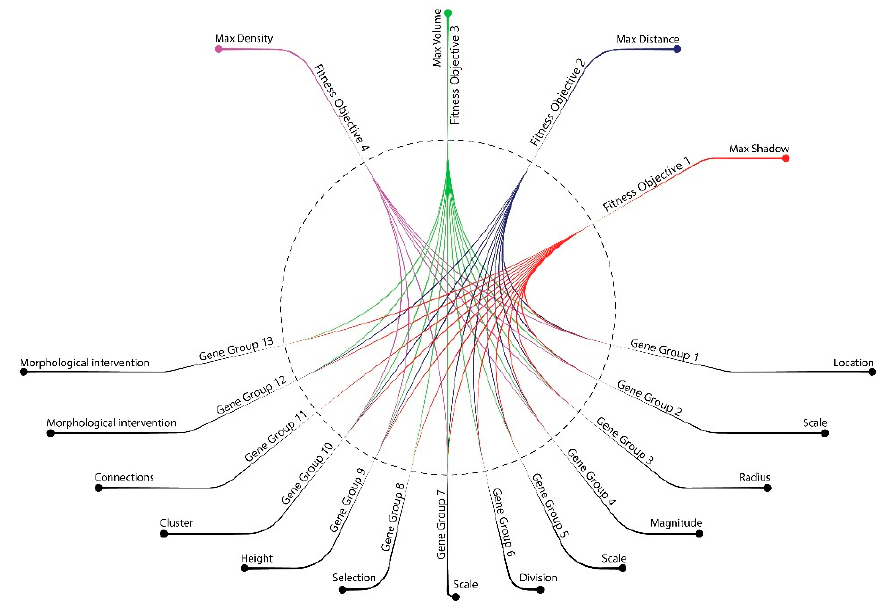
Figure 9. The relationship between the fitness functions and chromosomes defining the design problem.